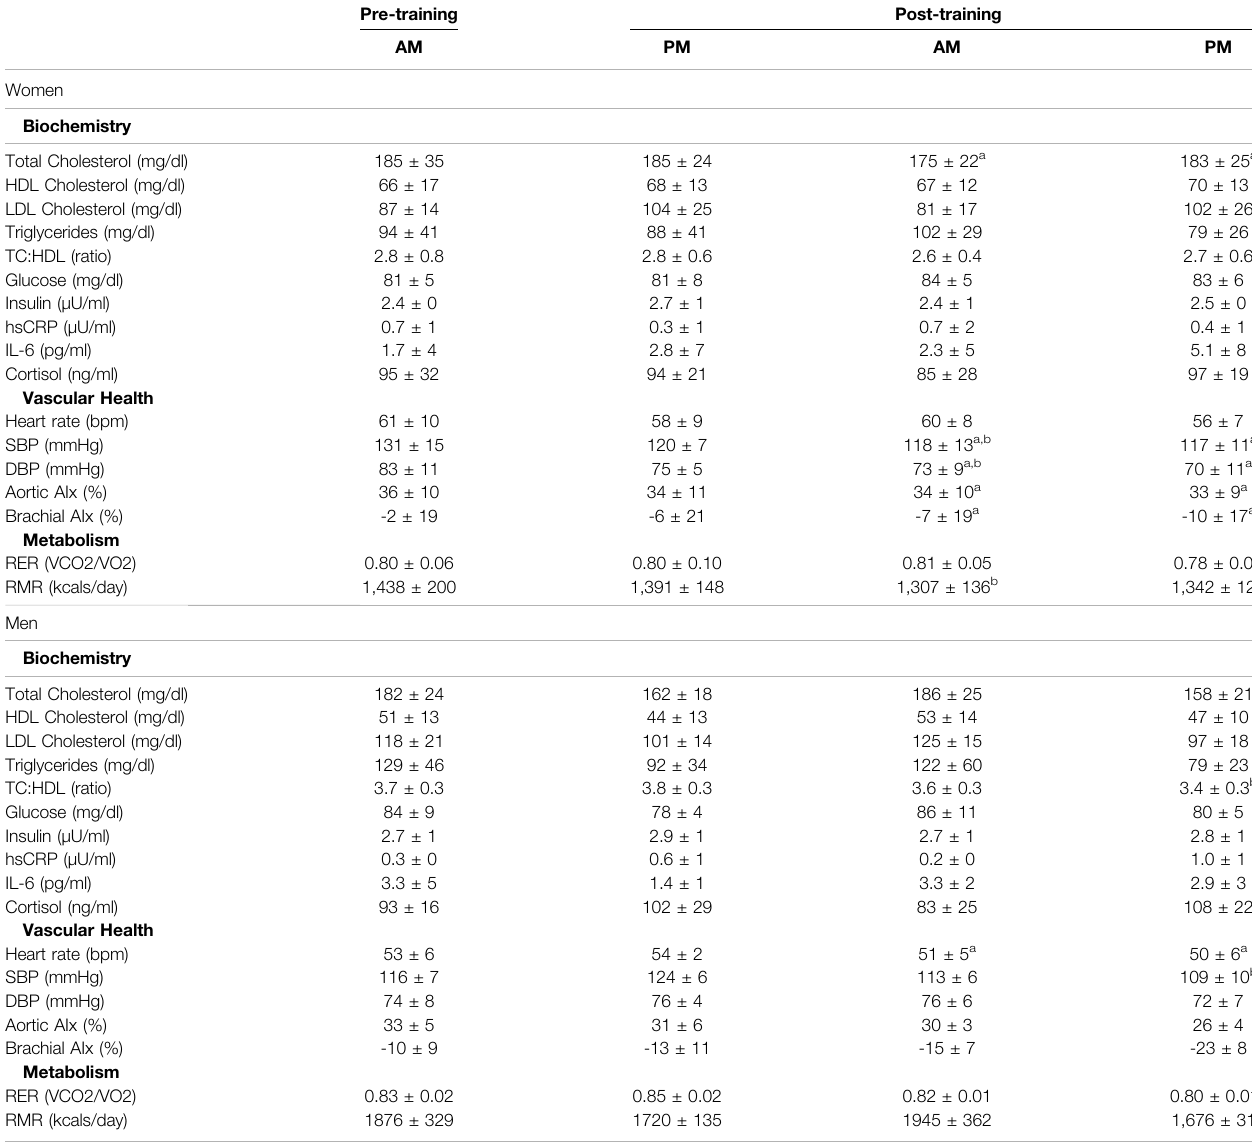
TABLE 4 | Cardiometabolic changes between AM vs PM exercisers during the 12-week RISE exercise intervention for women and men.